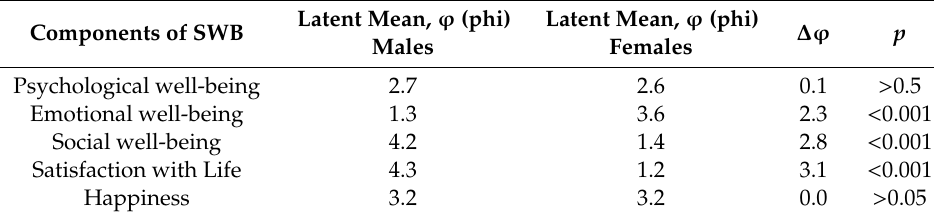
Table 4. Latent means for gender groups.